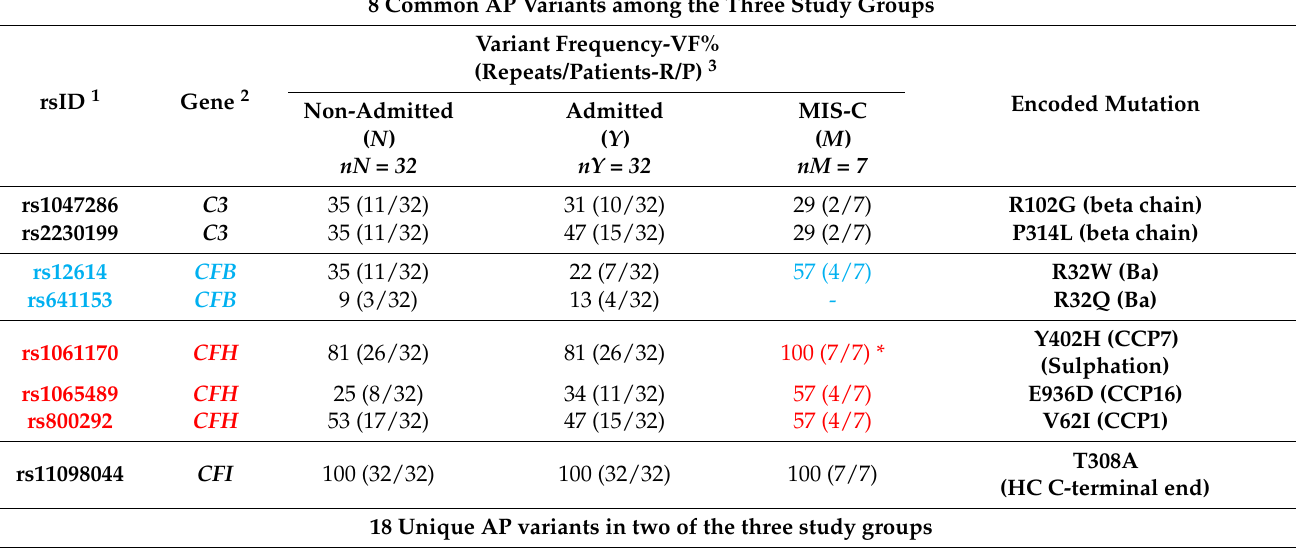
Table 2. The human alternative pathway (AP) associated complement missense coding SNPs detected in pediatric COVID-19